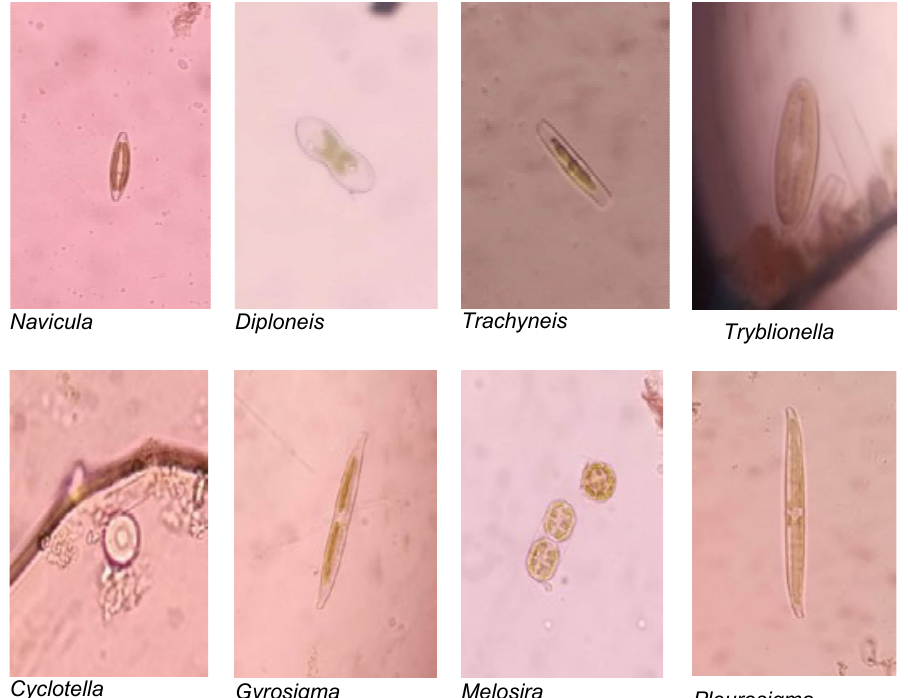
Fig. 2b: Several microalgae found in Sempu Island (magnification 4x10)